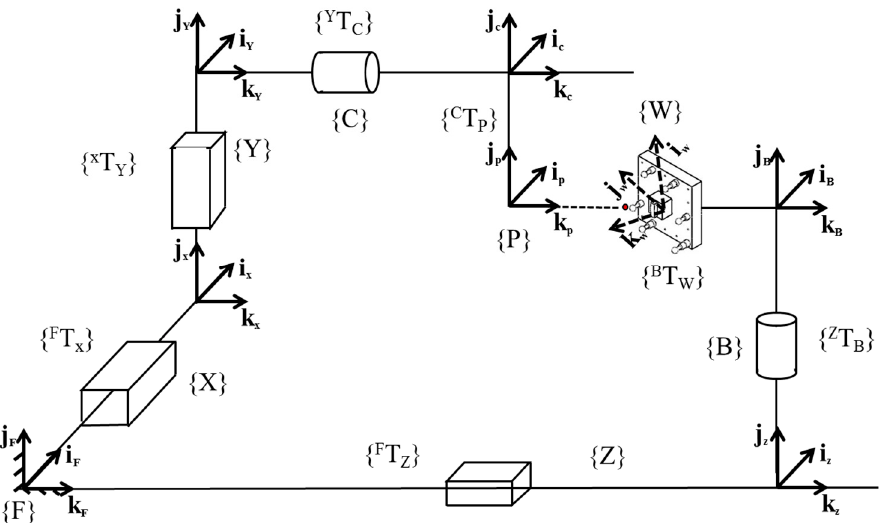
Figure 4. Topological construction of the five-axis ultra-precision fly-cutting machine tool. proach to connect the positions of the fiducials in different coordinates and each single error can be synthesized as a volumetric